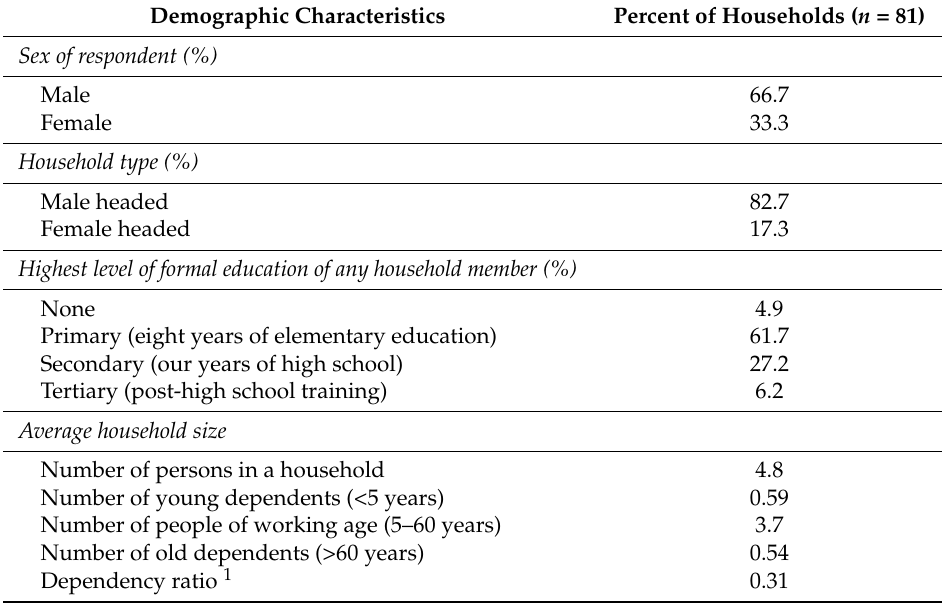
Table 1. Household